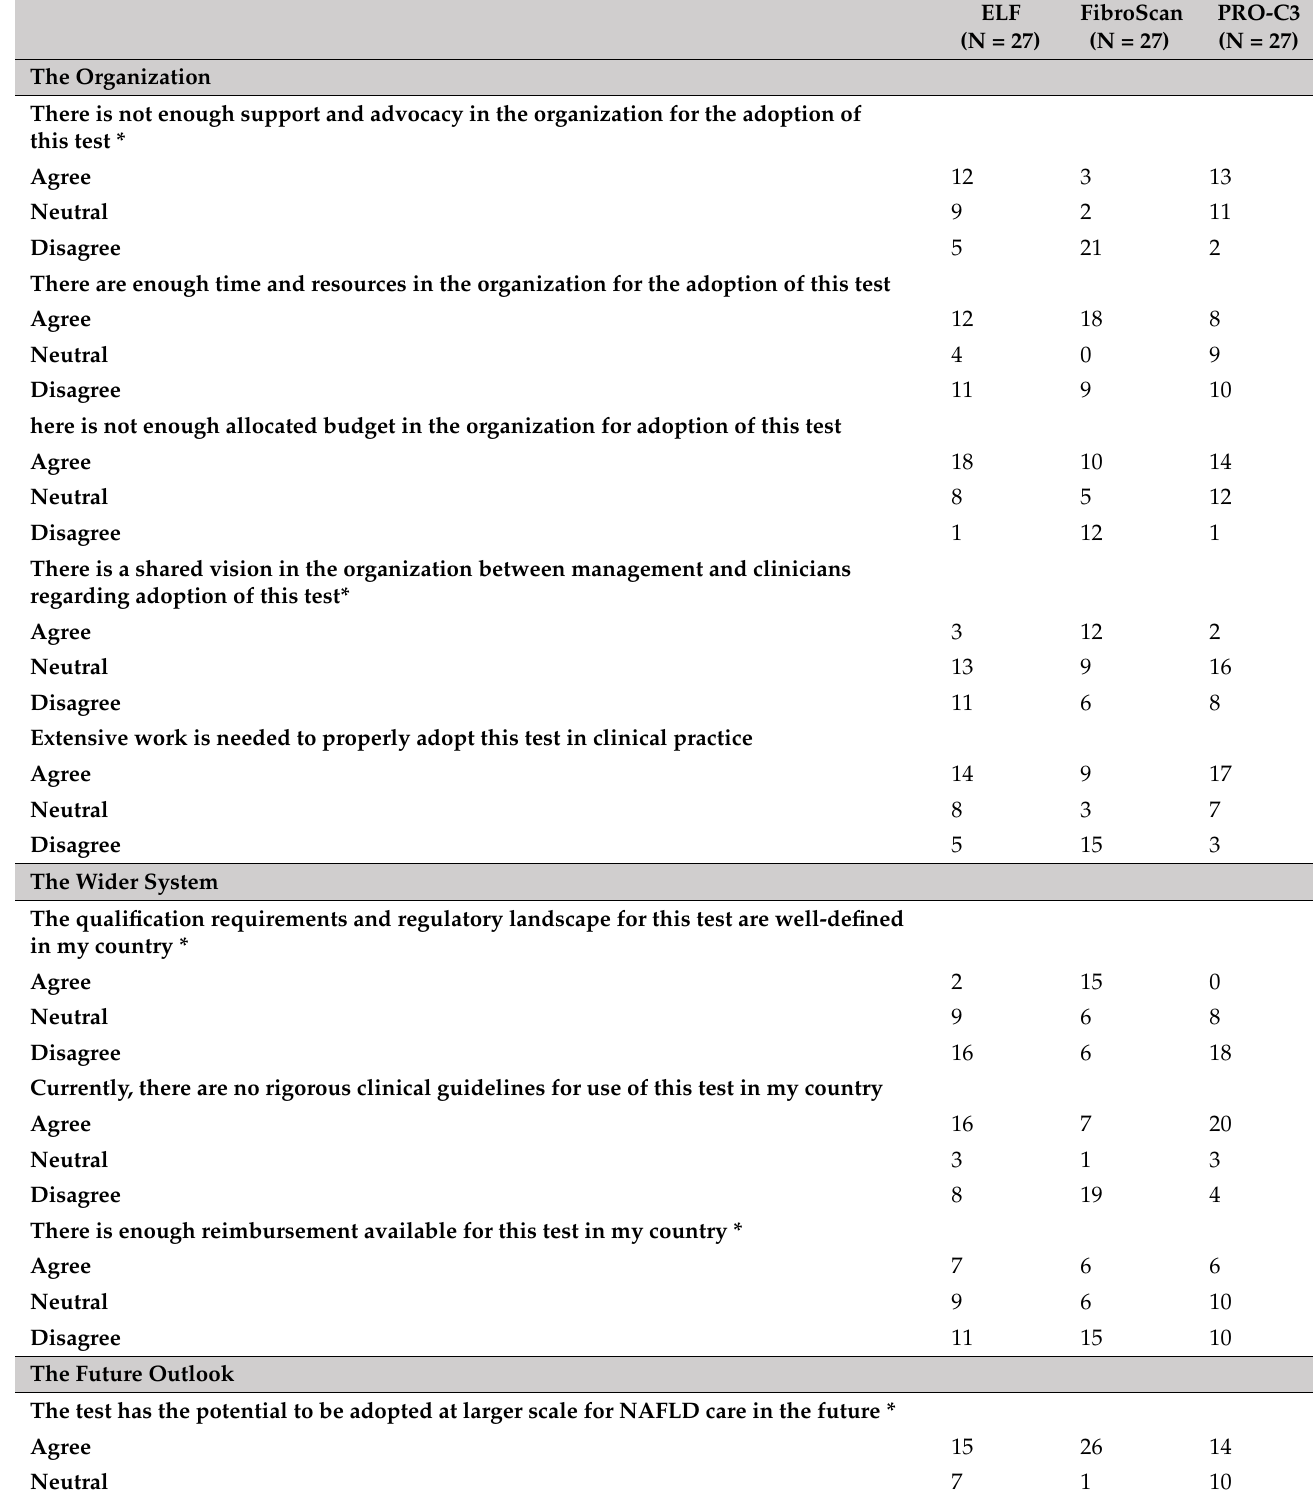
Table 5. Results per items of “The Organization”, “The Wider System”, and “The Future Outlook” do- mains of the Non-adoption, Abandonment, Scale-up, Spread, and Sustainability (NASSS) framework as reported by